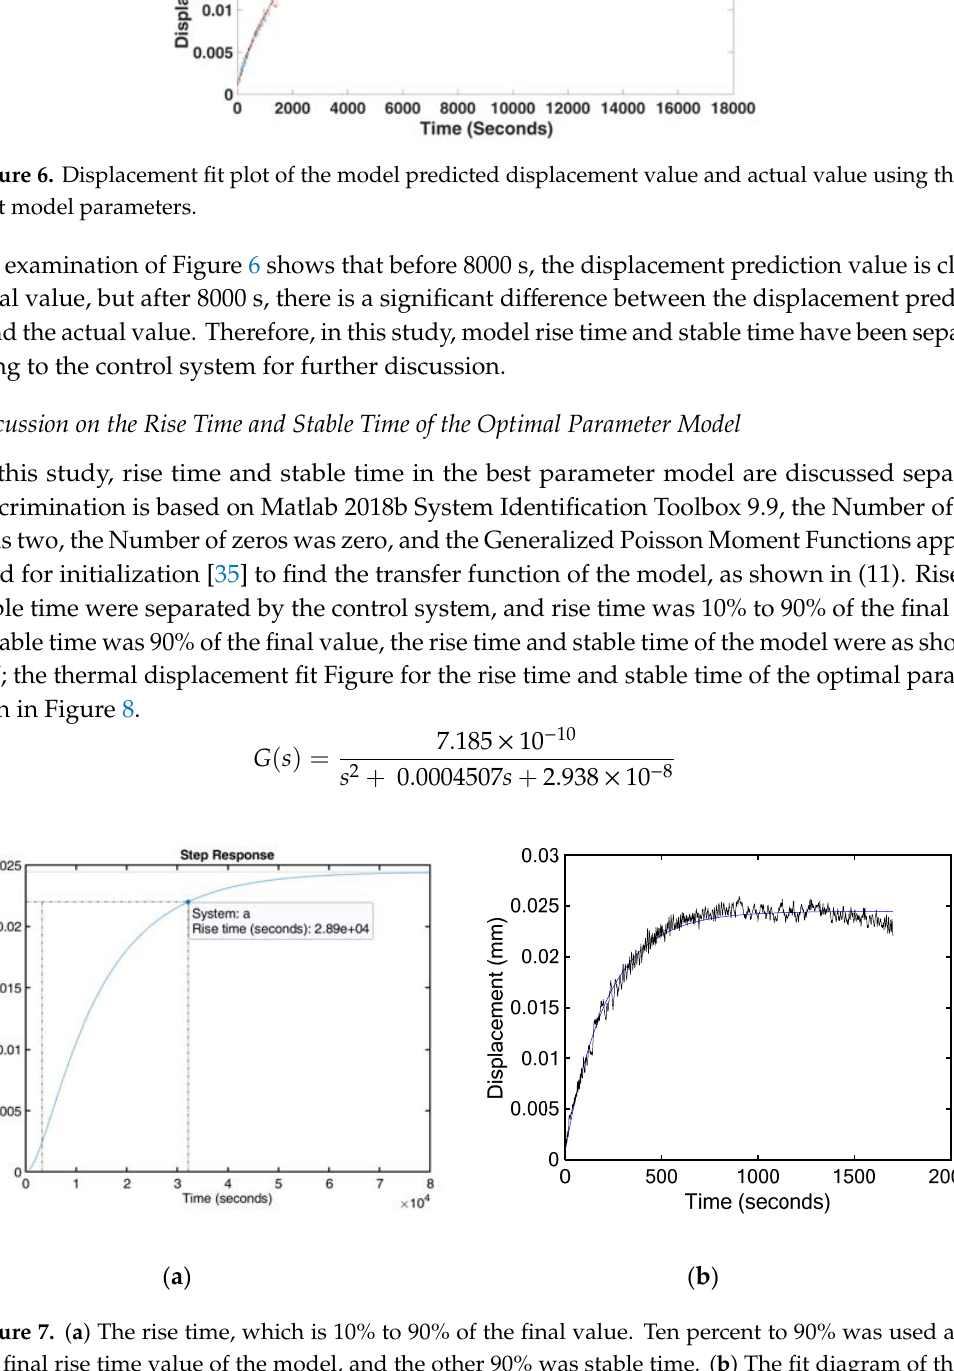
( b ) Figure 8. Fit Diagram of the rise time and stable time of the optimal parameter spindle thermal displacement model. In ( a ), the difference of actual displacement value and predicted displacement